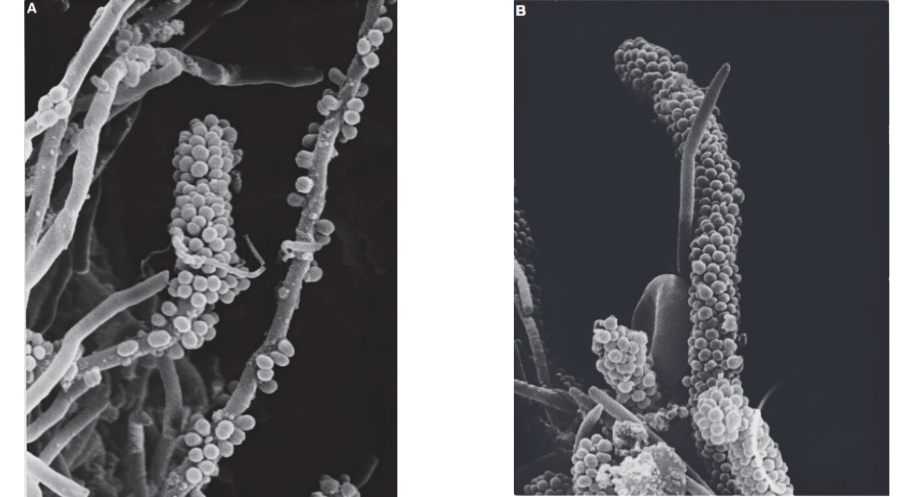
Figure 1. ( A ) Co-aggregation between S. mutans and filaments in developing dental biofilm; ( B ) ( B ) typical corncob formation typical corncob formation [30] .